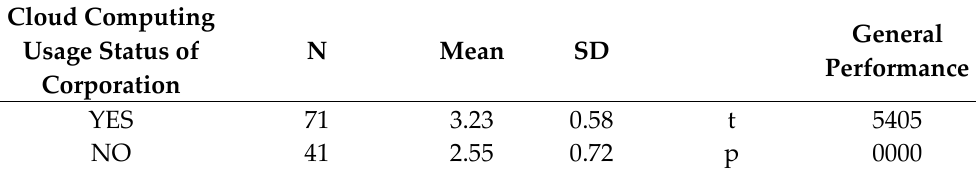
Table 1. Diversification situations of participant’s points gained from general performance scale with respect to cloud computing usage status of the